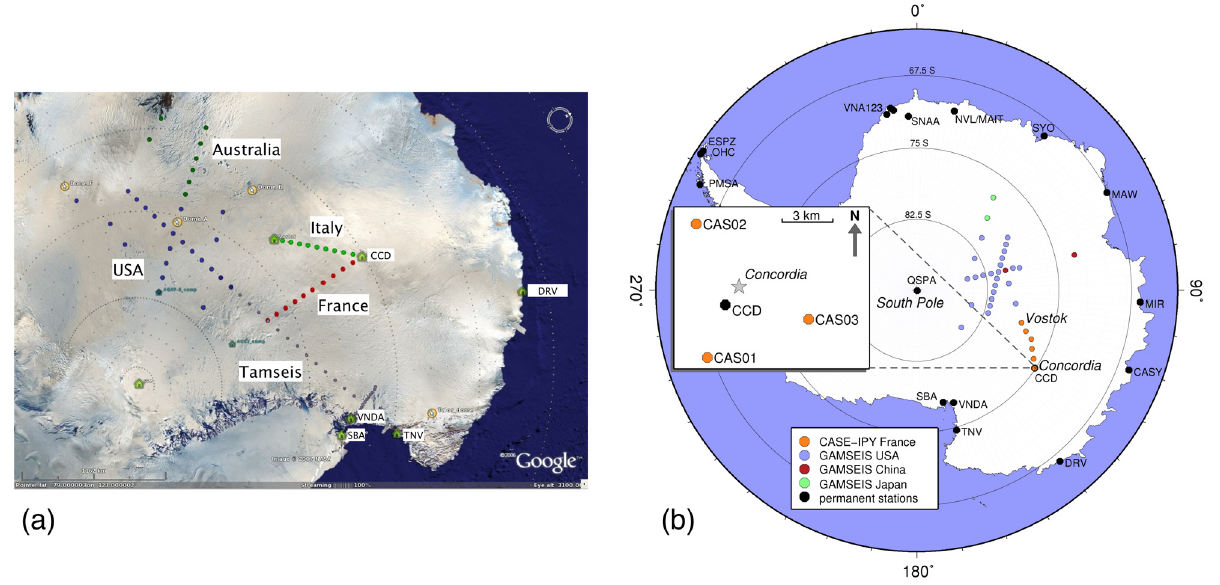
Figure 2. The East Antarctica IPY deployments. (a) As planned at the time of the submission of the funding application for the CASE-IPY experi- ment (February 2007). The earlier TAMSEIS deployment is also shown. (b) As deployed in the field at the time of the CASE-IPY deployment